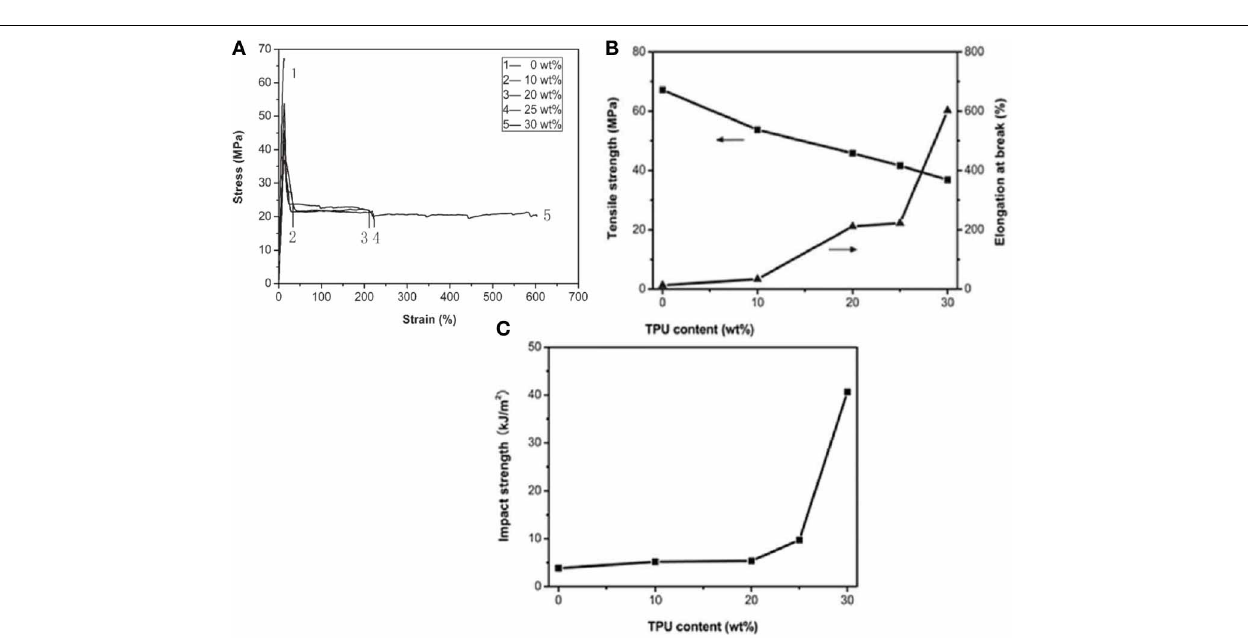
FIGURE 7 | (A) Stress–strain curves, (B) Tensile properties, and (C) Impact strength of PLA/TPU blends with different TPU contents. Copyright (2011) Wiley; used with permission from Han and Huang (2011).